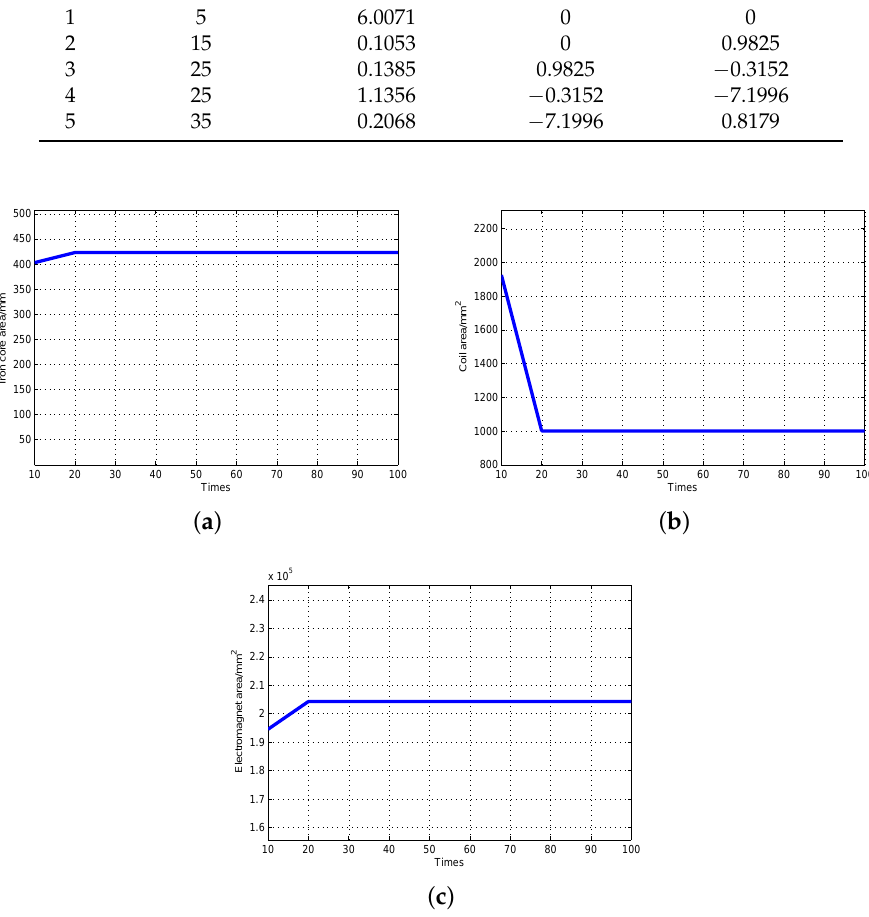
Table 1. Comparison between different particle nodes number of adaptive PSO algorithm. No. Particles Number Expectation E p